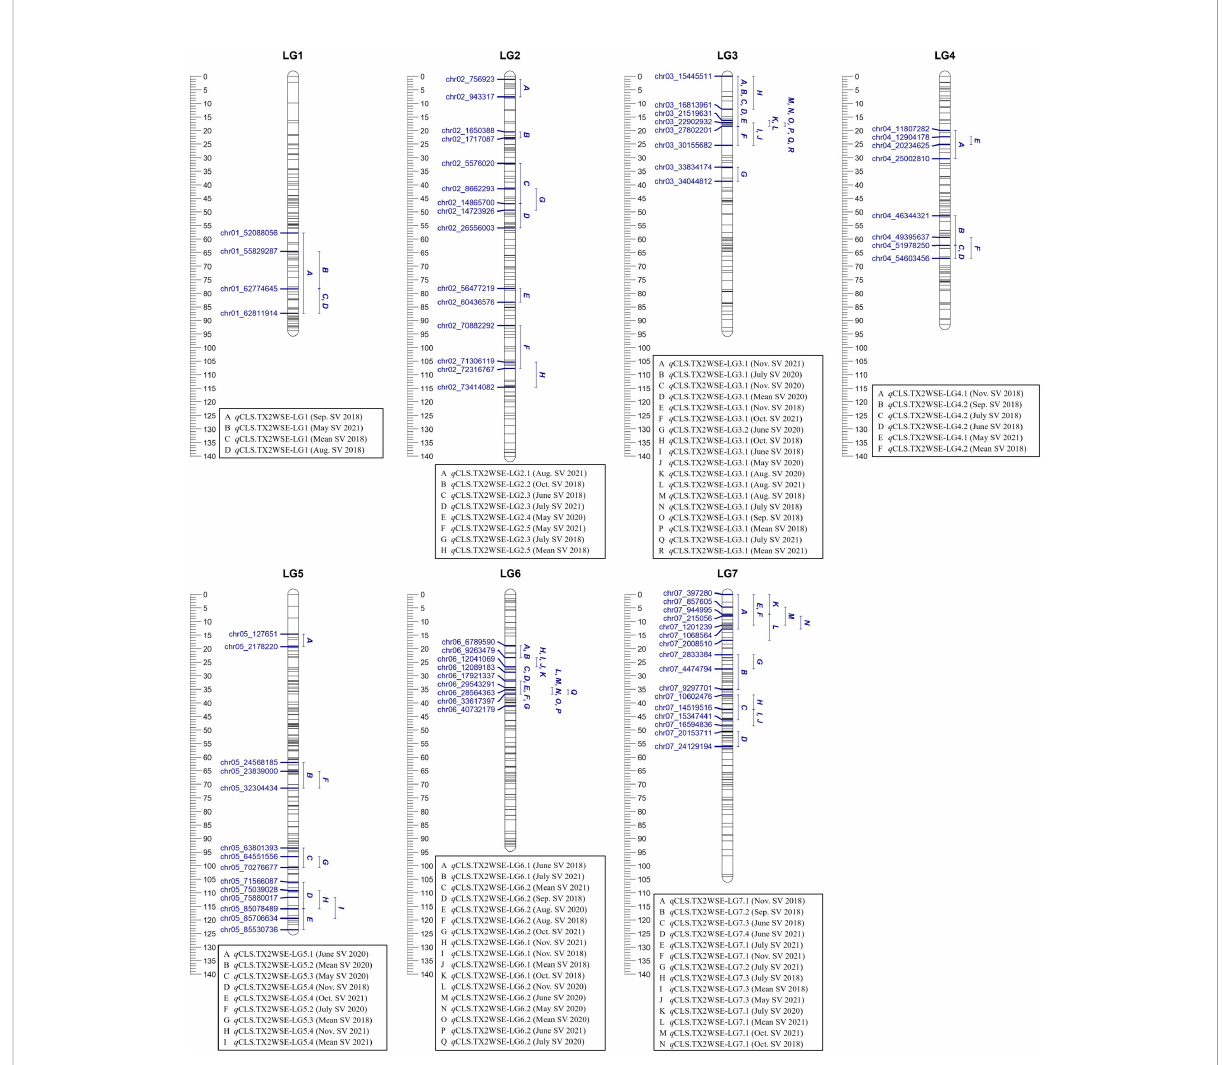
FIGURE 2 Positions of putative QTLs controlling the cercospora leaf spot disease (CLS) incidence across six diploid rose populations at linkage groups (LG) of the three-population (TX2WSE) consensus map. QTL names are listed below each LG. The plot generated using MapChart